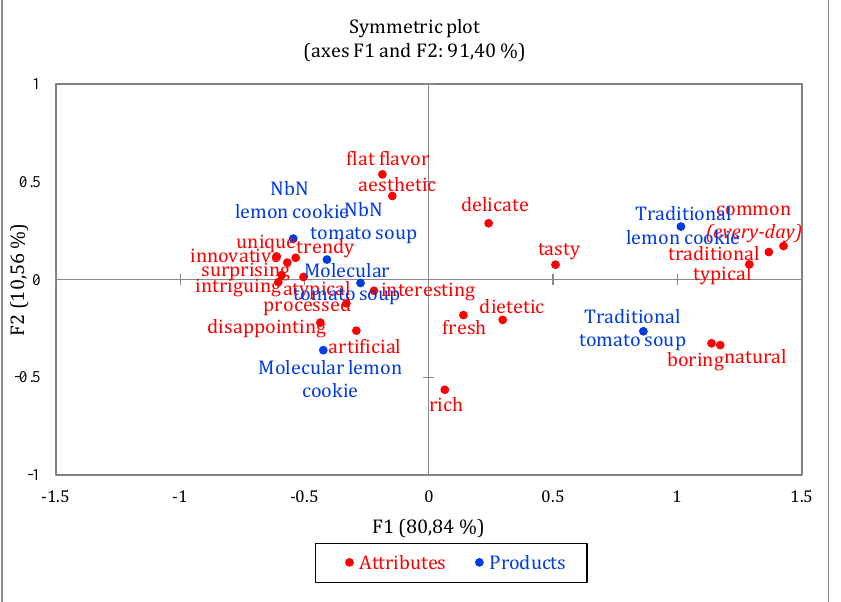
Figure 4. The dishes and term representation in the first and second coordinates of the Corre- spondence Analysis performed on the frequency of use of attributes by consumers (according to check-all-that-apply).